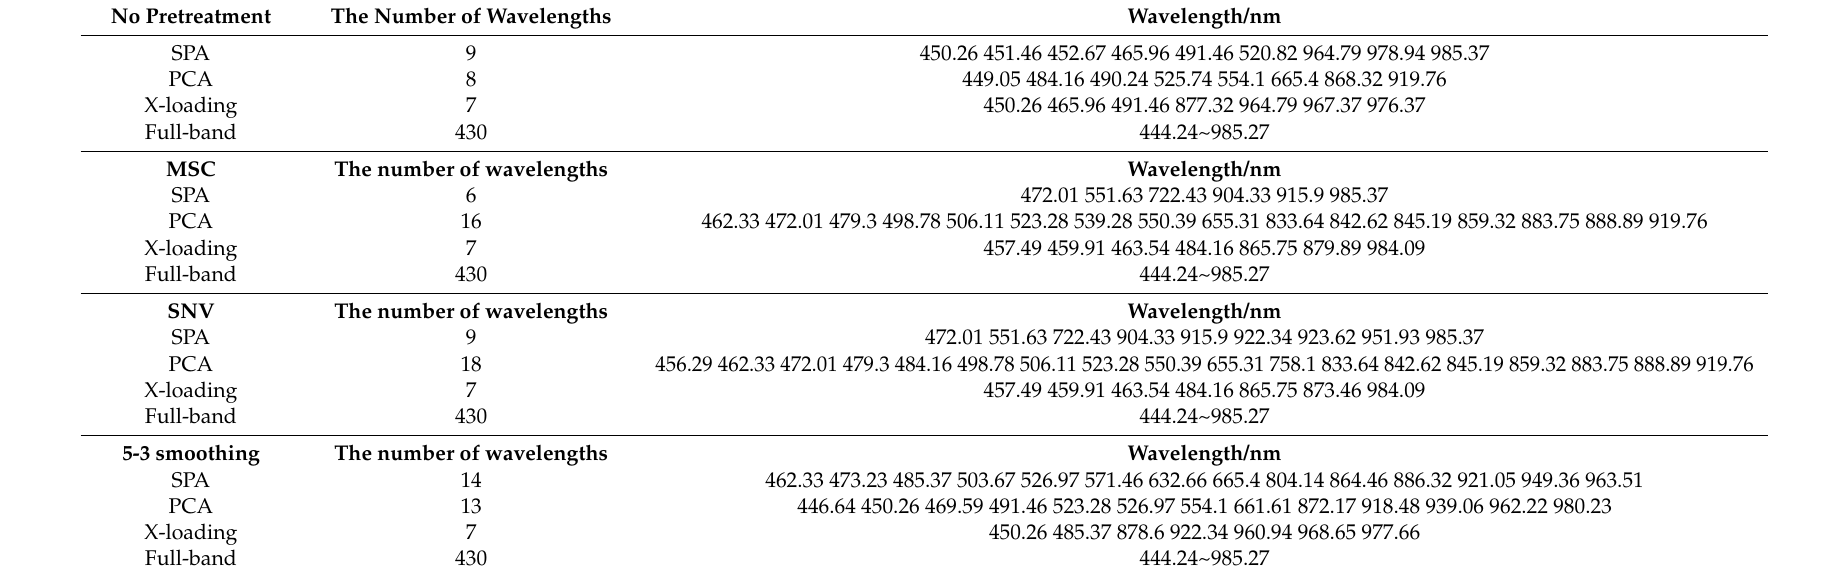
Table A3. The selected wavelengths using different methods under different pretreatments of